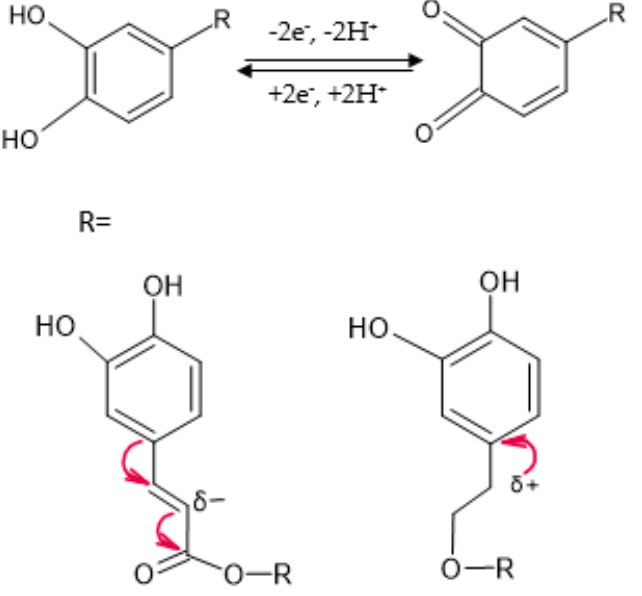
Figure 9. Oxidation mechanism of catechol moiety in verbascoside structure.